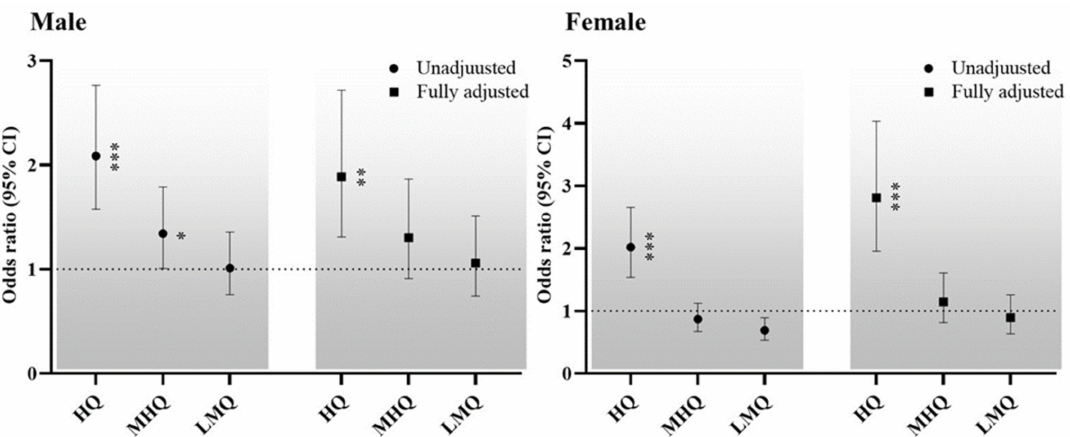
Figure 2. Sex-specific ORs for the relationship between ABSI and osteoporosis. Dotted line: reference; solid line: 95% confidence interval; Black circle: ORs. * p < 0.05, ** p < 0.01, *** p < 0.001 for the ORs for osteoporosis, compared with the lowest quartiles. Abbreviations: HQ, highest quartile; MHQ, middle-high quartile; LMQ, low-middle quartile.